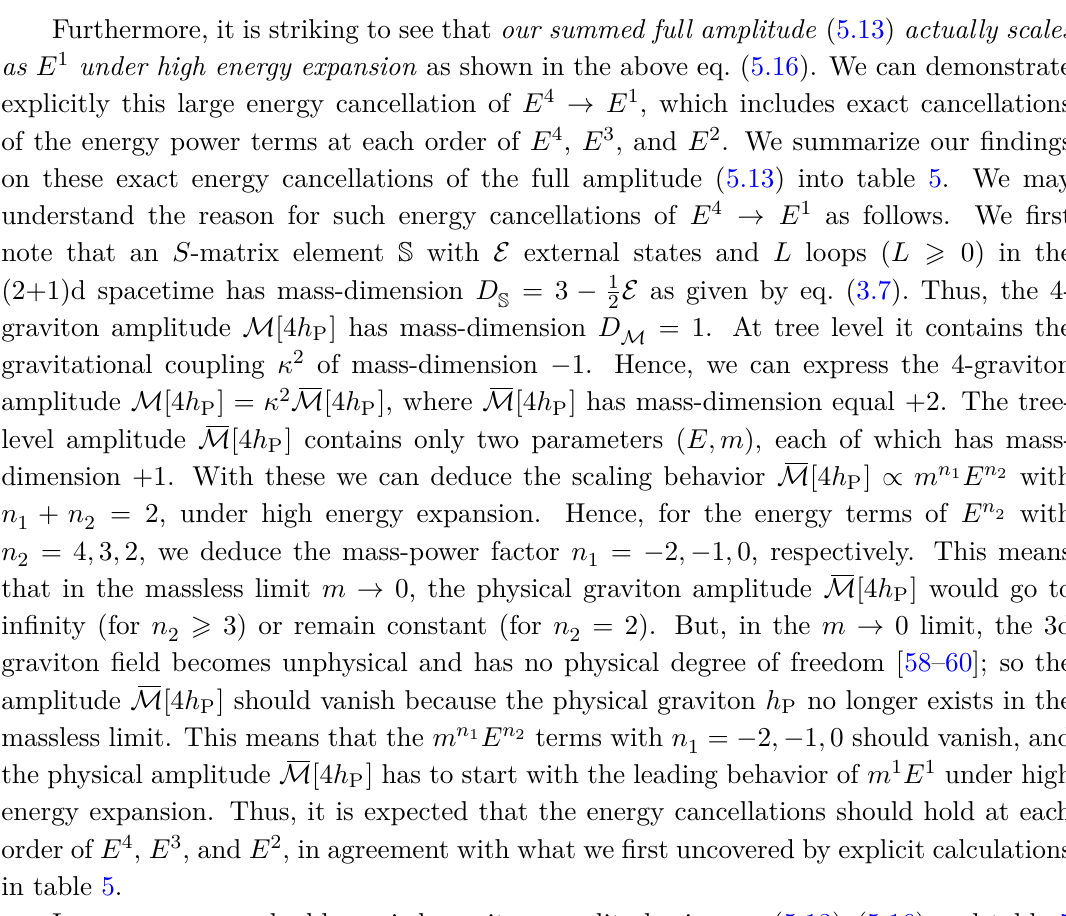
Table 5 . Exact energy cancellations at each order of E 4 , E 3 , and E 2 in our 4-graviton scattering amplitude (5.13) by double-copy construction. Here the notations ( s and s = 4 E 2 β 2 . A common overall factor ( κ 2 m 2 / 1024) in each amplitude is not displayed for 0